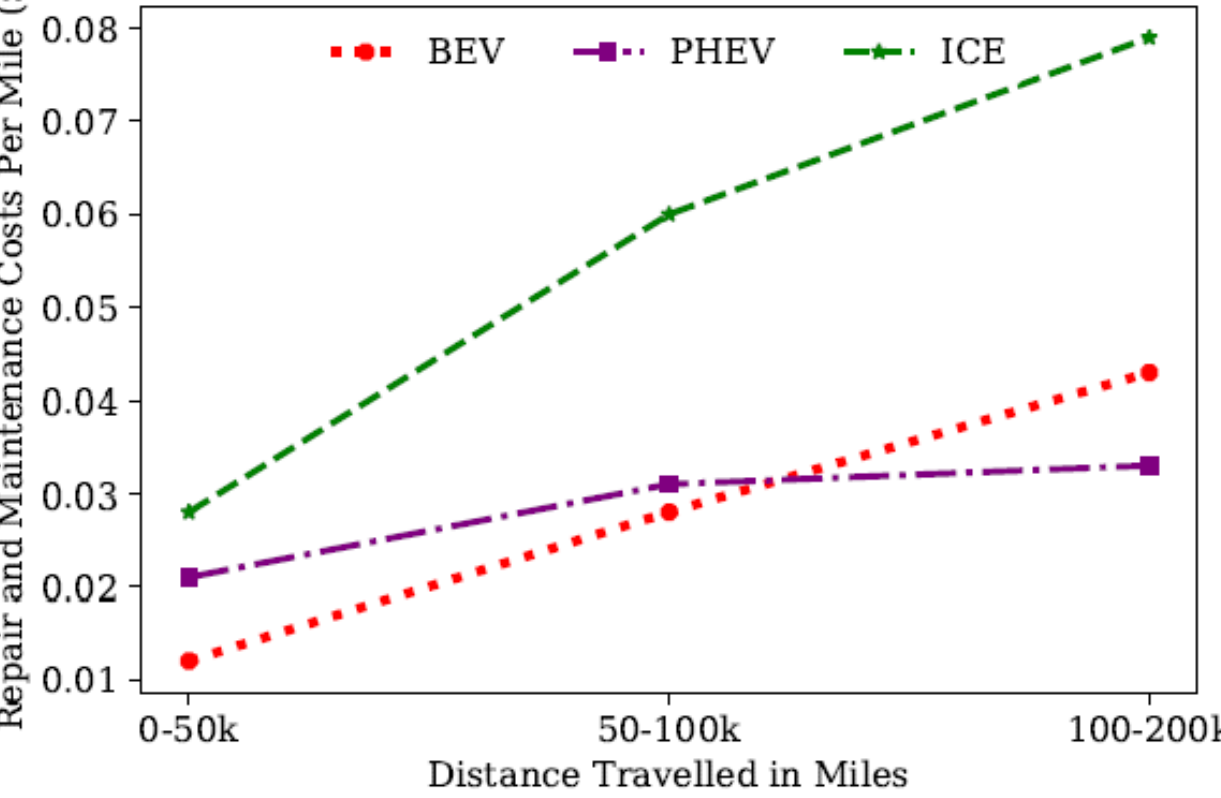
Figure 4. Per mile repair and maintenance costs of BEVs, PHEVs, and ICEs with different travelled distances. Table 1. Lifetime maintenance and repair cost.